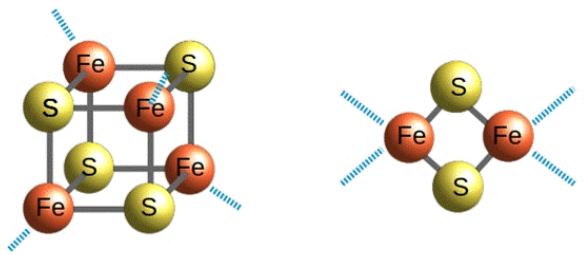
Figure 1. Schematic structures of rhomboid [2Fe-2S] and cubane [4Fe-4S] clusters.